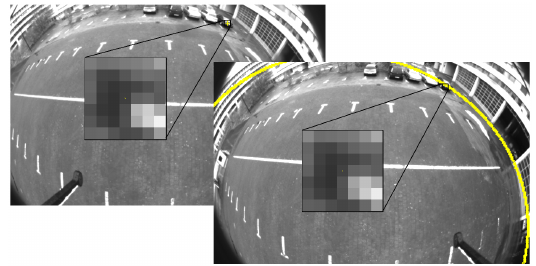
Figure 4: Example images taken in a synchronized way in the left and right camera of a stereo pair. The extracted feature point in the left image on the rightmost car has the illustrated epipolar line in the right image. The matching point in the right image lies on the indicated yellow line and the corresponding local image patches show a high correlation.